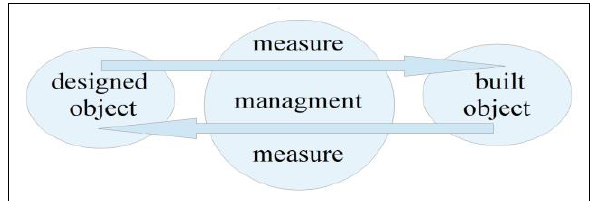
Figure 1. Iterative procedure: model, measure,